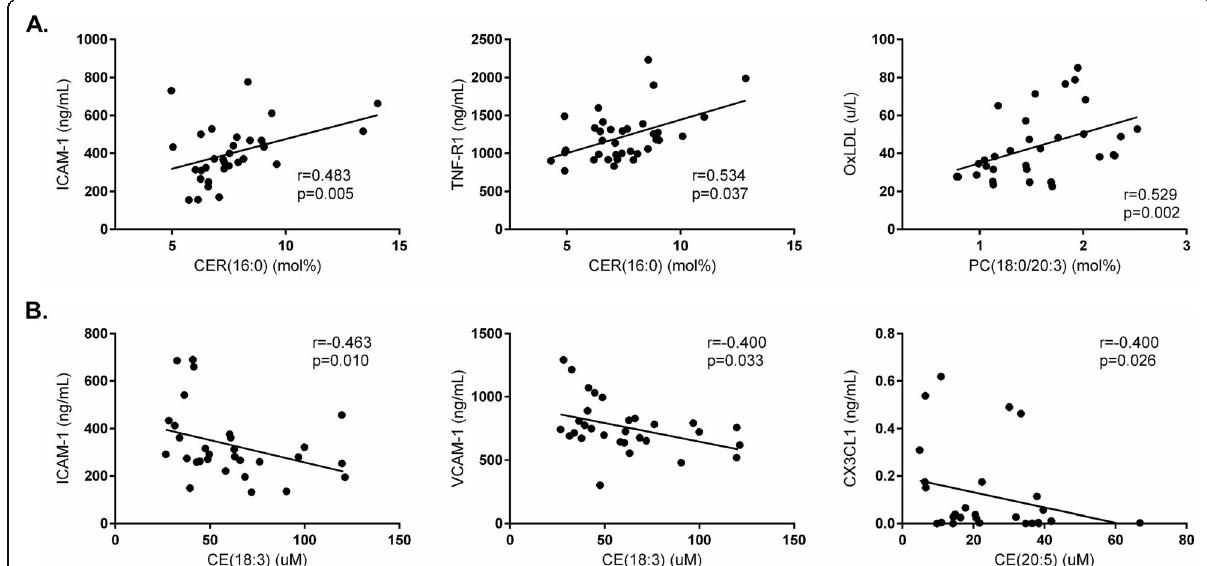
Fig. 3 Lipid species associated with CVD risk correlate with soluble biomarkers of inflammation Plasma samples were thawed and levels of soluble inflammatory biomarkers (ICAM-1, VCAM-1, sTNF-R1, CX3CL1, OxLDL) were measured by ELISA. a Spearman correlations demonstrate direct relationships among inflammatory marker levels and lipid species positively associated with CVD risk. b Levels of lipid species previously shown to be negatively associated with CVD risk were also negatively associated with inflammatory markers in PWH after initiation of